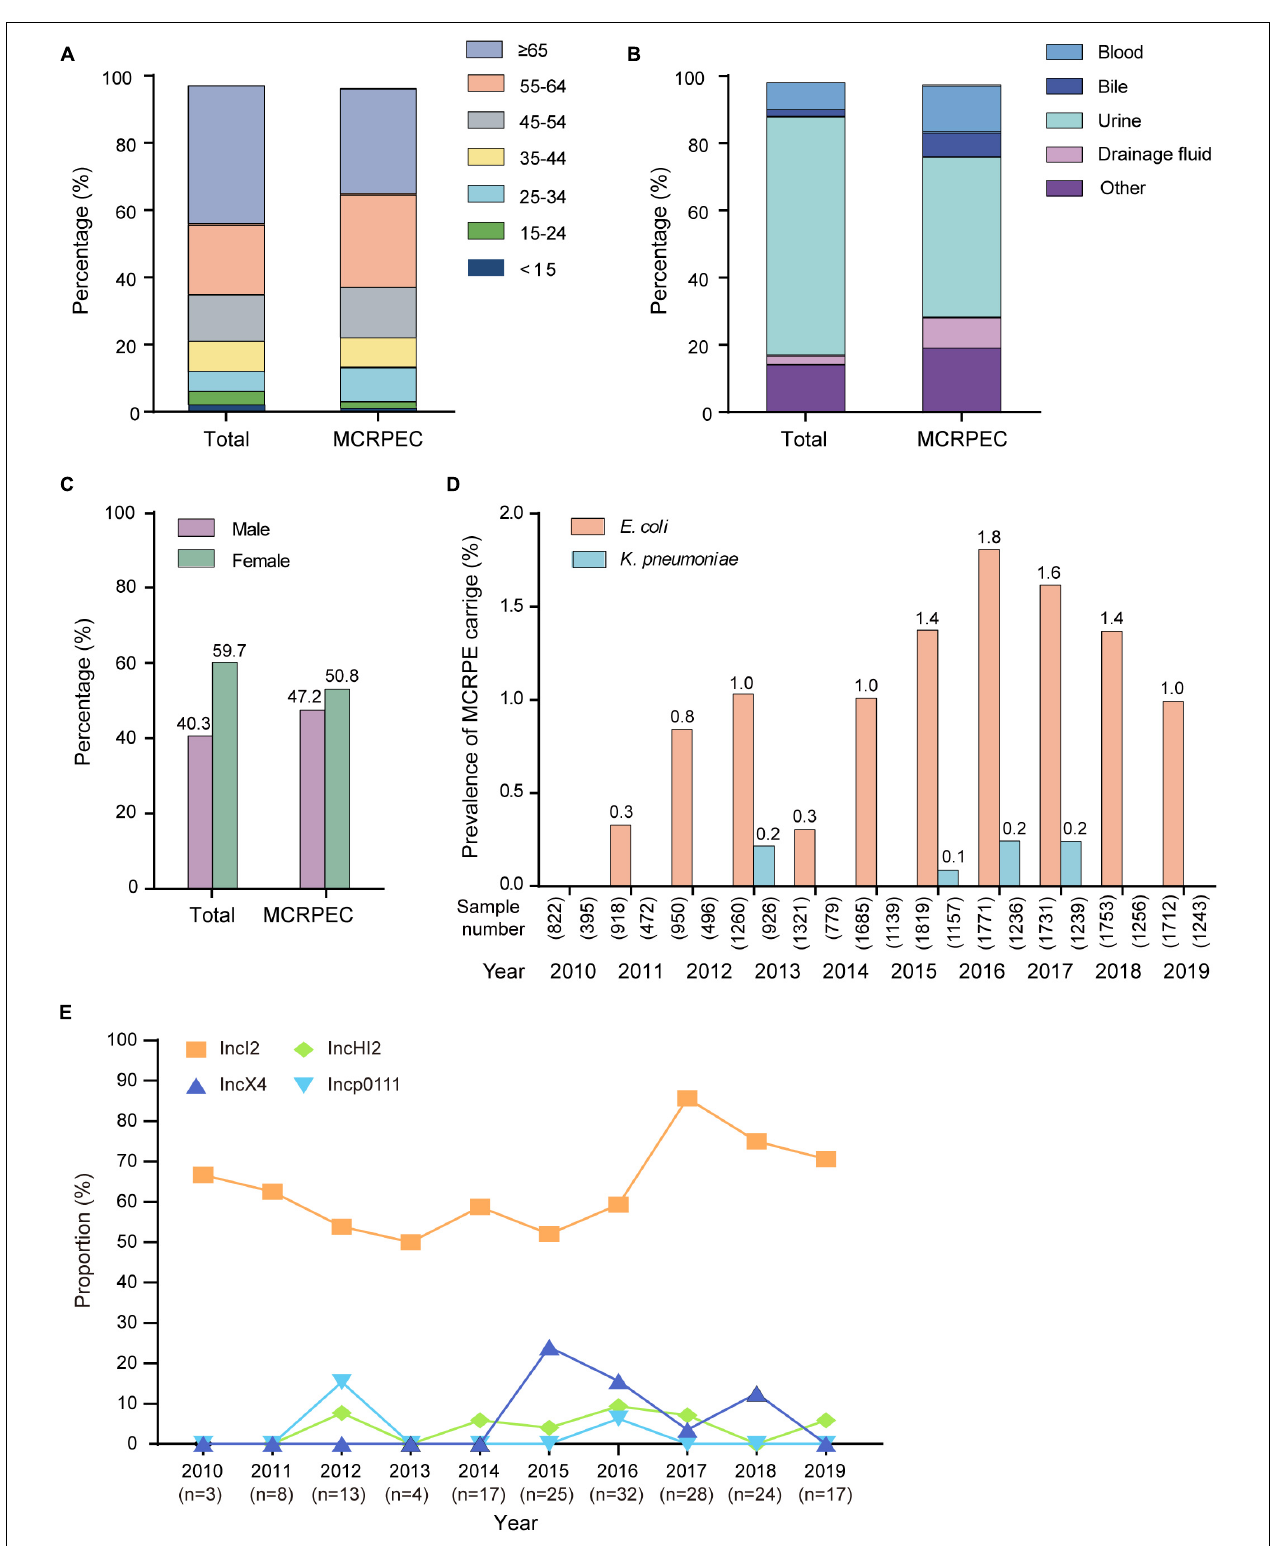
FIGURE 1 | Summary of information. (A) The age distribution of the total sample population and mcr-1 -positive E. coli (MCRPEC). (B) The specimen type distribution of the total sample population and MCRPEC. (C) The sex distribution of the total sample population and MCRPEC. (D) The prevalence of mcr-1 -positive Enterobacteriaceae (MCRPE) during 2009–2019. (E) The prevalence of main plasmids types in all MCRPEC during 2010–2019.